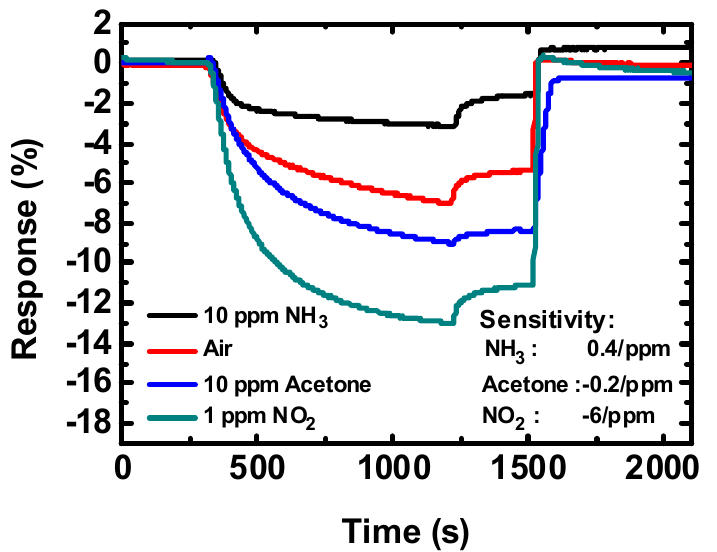
Figure 4. Selectivity of the NO 2 graphene sensor to different